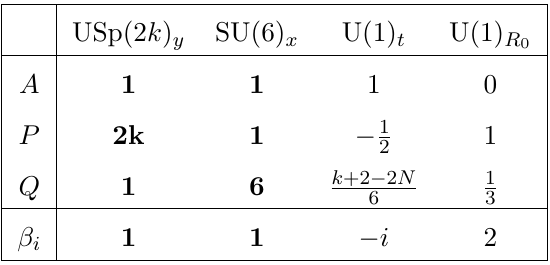
Table 8 . Transformation properties under the global symmetry F A of the matter fields of Theory A. The horizontal line separates fields charged under the gauge symmetry from the